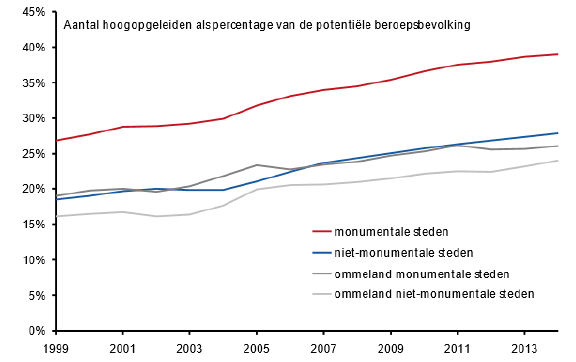
Figure 2. In red: number of highly educated people as a percentage of the potential labour force in historical cities in the Netherlands (Marlet,